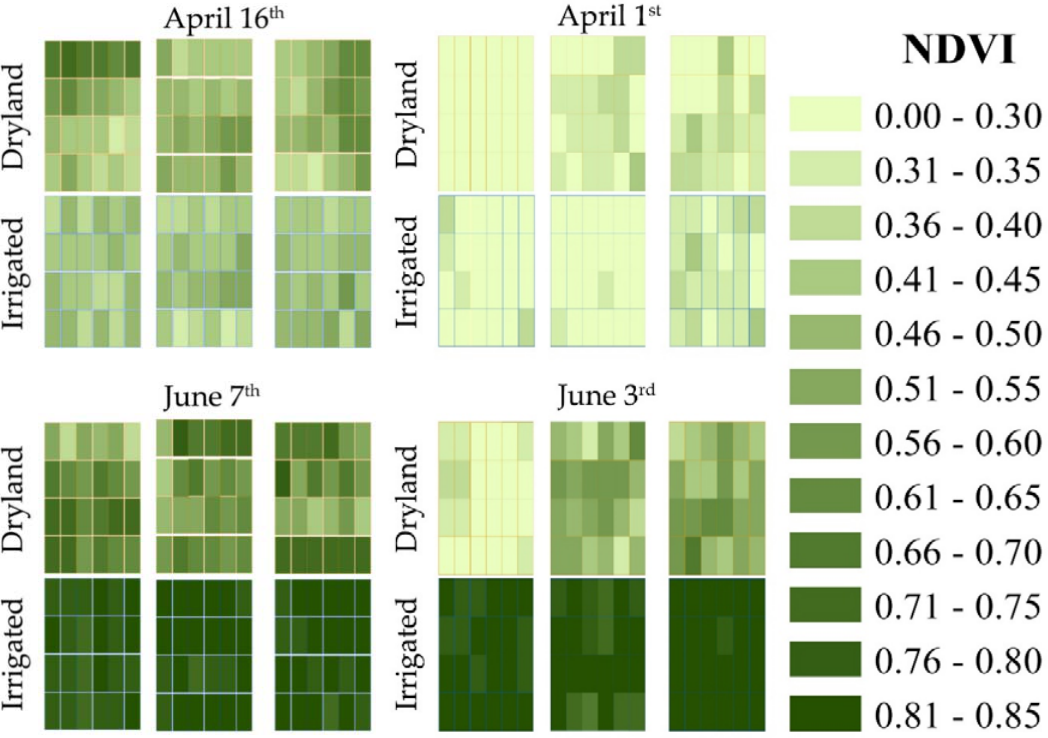
Figure 3. Map of average NDVI values for each genotype of each replication for both dryland and irrigated plots on April 16th and June 7th in site-year I (left panel), and April 1st and June 3rd in site-year II (right panel). Actual location of the replications relative to each other was modified to accommodate this figure.